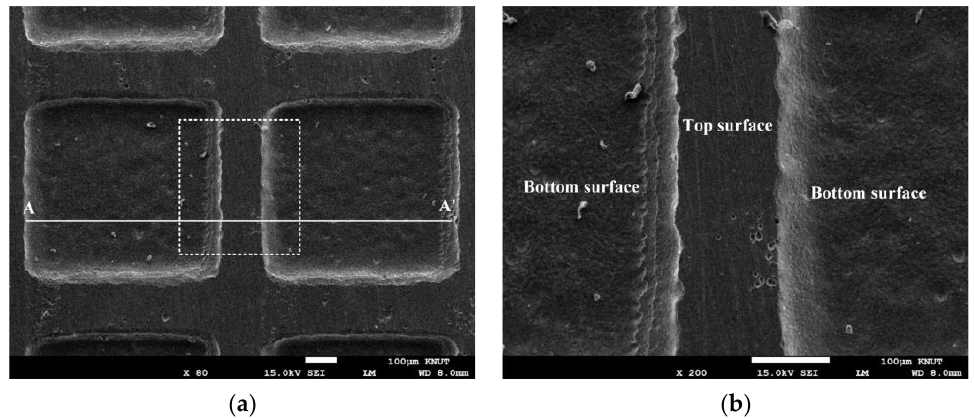
Figure 5. SEM image of taper angle after repeating DEE process 10 times at excessive etching time (etching voltage: 10 V, etching time: 10 s): ( a ) square pattern; ( b ) magnified image of the square dotted line area in ( a ).